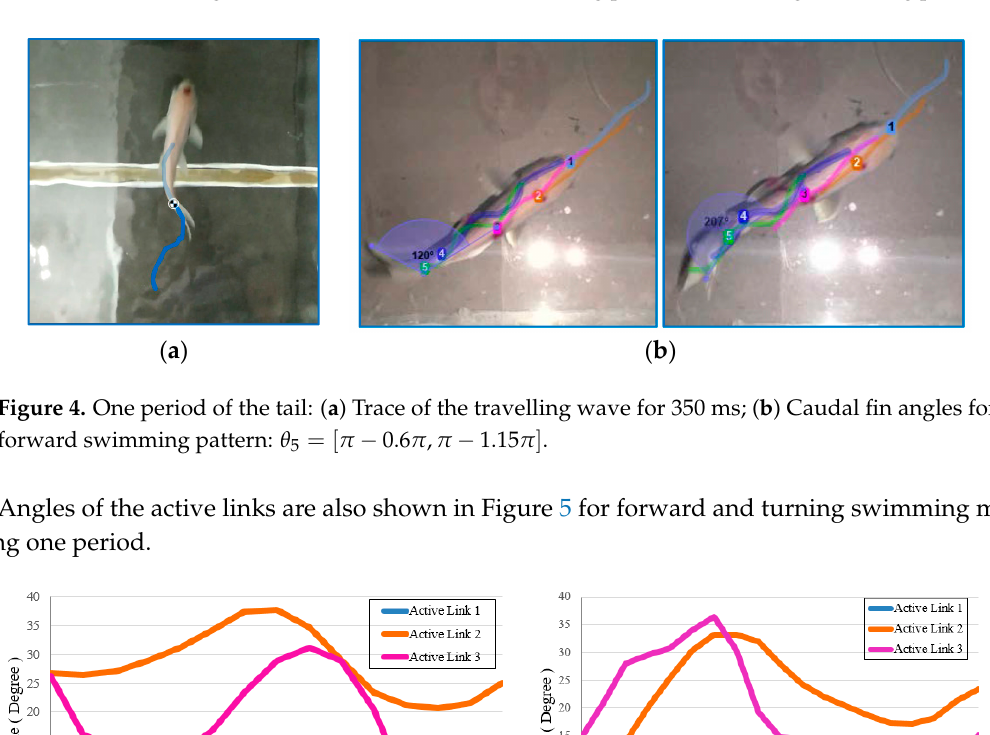
Figure 3. Path tracking of the all links: ( a ) Forward swimming pattern; ( b ) Turning swimming pattern.